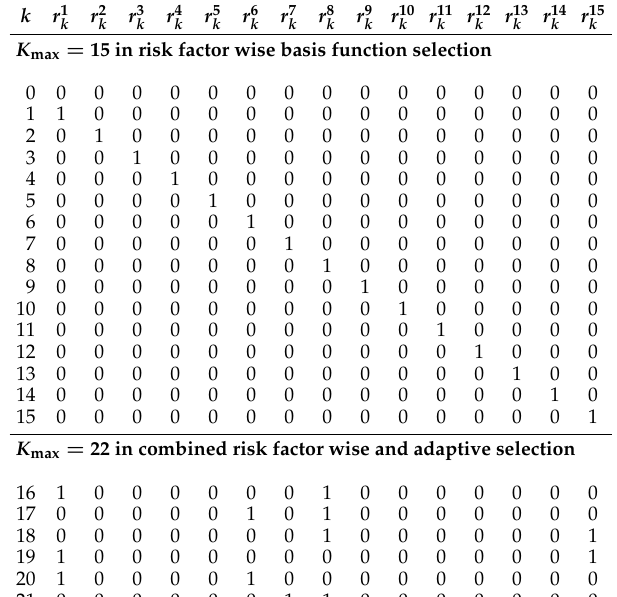
Table A34. Basis function sets of LC and LL proxy functions of BEL corresponding to K max derived by risk factor wise or combined risk factor wise and adaptive OLS